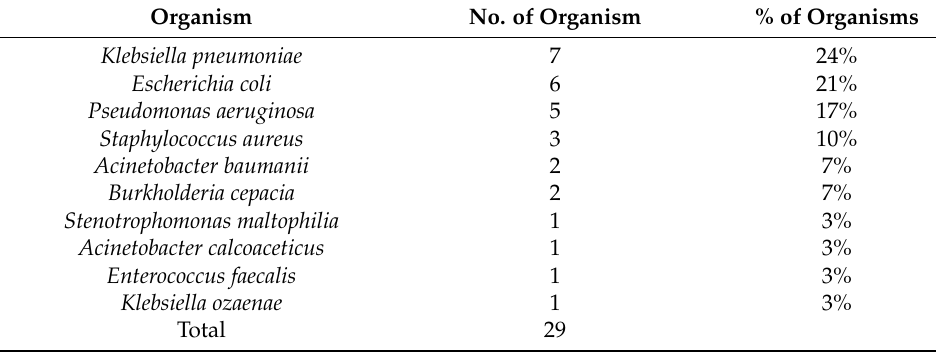
Table 3. Bacterial pathogens isolated from C. auris patients. Organism No. of Organism % of